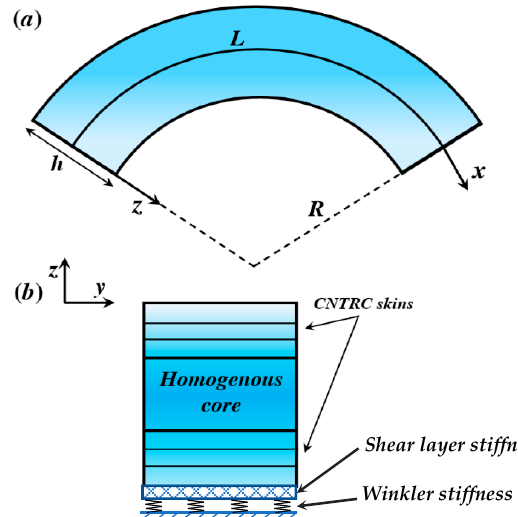
Figure 1. Geometry of a carbon nanotube reinforced composite (CNTRC) curved sandwich beam: ( a ) geometric parameters of the curved beam, ( b ) cross-section of the curved beam.